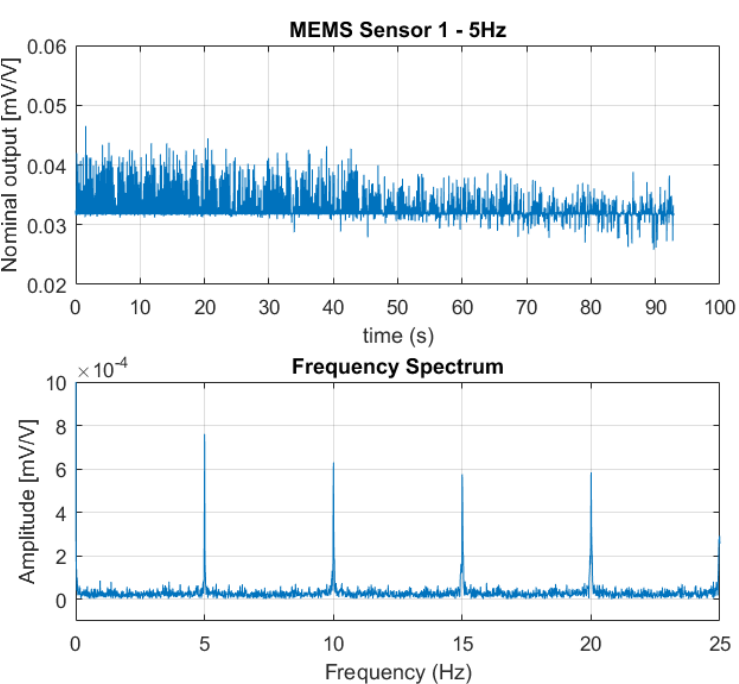
Sensors 2018 , 18 , x FOR PEER REVIEW 7 of 11 Figure 6. The output signal from one of the sensors in the MEMS-based sensor system as a response to the 5 Hz excitation vibration ( above ) together with fast Fourier transform of the data set ( below ). The fast Fourier Transform clearly shows the fundamental excitation frequency at 5 Hz with an amplitude far above the noise floor; also, the higher order harmonics at 10 Hz, 15 Hz, and 20 Hz are visible.